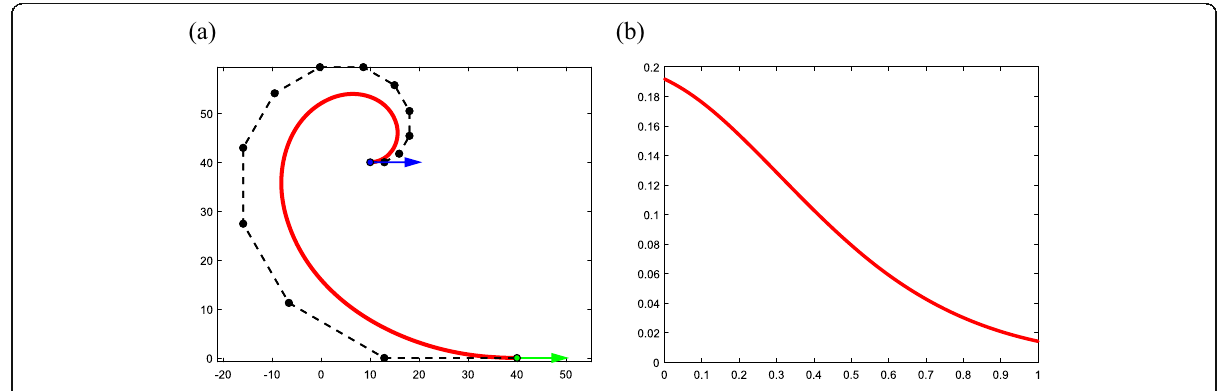
Fig. 8 An instance of case II. a : Typical curve obtained by the proposed algorithm; b : Corresponding curvature